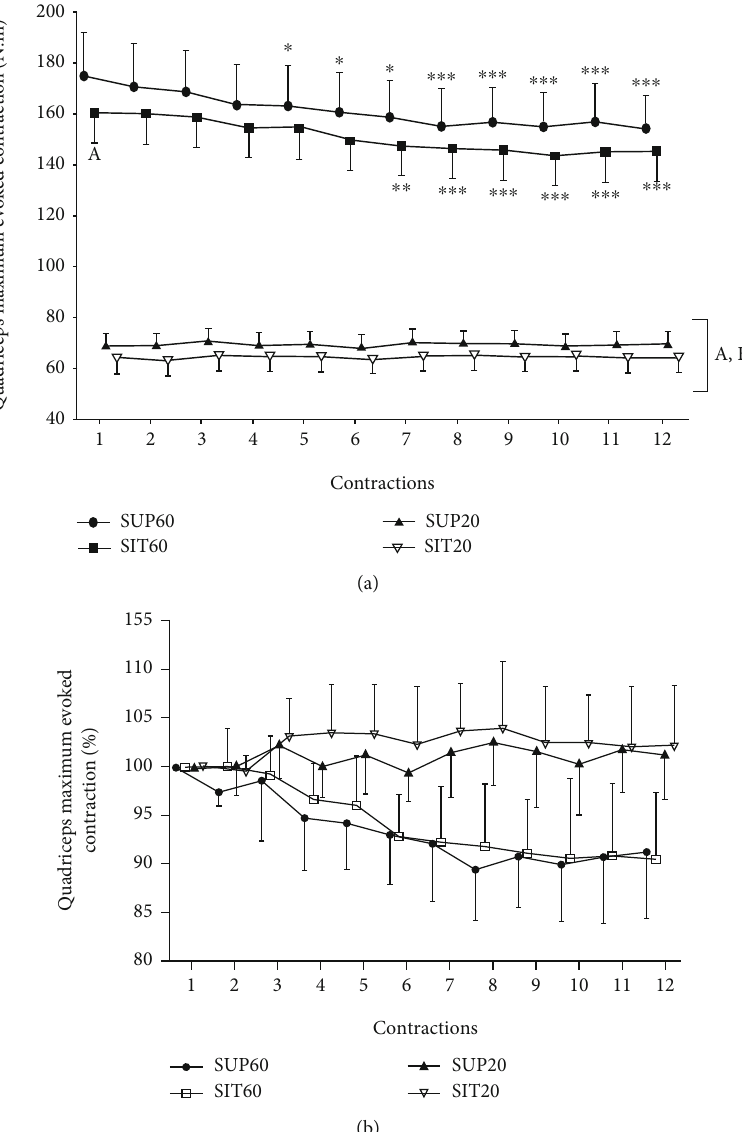
Figure 1: Quadriceps maximum evoked contraction in absolute (N.m; (a)) and relative (%; (b)) values during the 1st to the 12th contraction in the positions SUP60, SIT60, SUP20, and SIT20. Data are presented as mean and 95% CI. Abbreviations: SUP60: supine with knee fl exed at 60 ° ; SIT60: seated with knee fl exed at 60 ° ; SUP20: supine with knee fl exed at 20 ° ; SIT20: seated with knee fl exed at 20 ° . NMES: neuromuscular electrical stimulation. Statistically signi fi cant di ff erences: ∗ p < 0 : 05 vs. 1st contraction; ∗∗ p < 0 : 05 vs. 1st and 2nd contractions; ∗∗∗ p < 0 : 05 vs. 1st, 2nd, and 3rd contractions; a p < 0 : 05 vs. SUP60; b p < 0 : 05 vs.